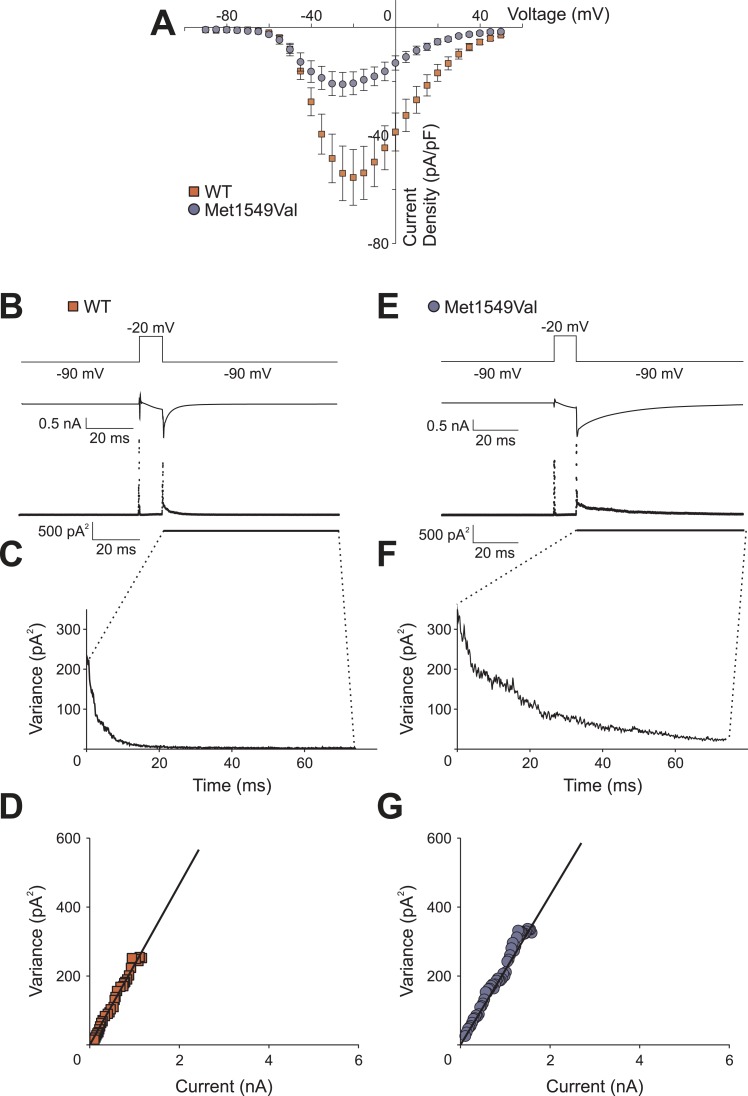
CACNA1HM1549V and CACNA1HWT whole-cell current densities and non-stationary noise analysis.(A) Whole-cell peak currents were divided by the cell capacitance as determined by the amount of capacitance compensation. CACNA1HM1549V shows a decreased current density compared to CACNA1HWT albeit with large variability. (B, E) Representative mean currents from more than 200 traces recorded from one cell expressing CACNA1HWT (B) or CACNA1HM1549V (E) channels. (C, F) Analysis of the variance at the −90 mV tail pulse reveals a time dependent decrease. (D, G) A plot of the variance vs the current only allows for a small initial part of the expected parabolic distribution to be visible. Linear fits (black line) reveal similar single channel amplitudes (CACNA1HWT: 273.7 ± 3.2 fA, n = 3; CACNA1HM1549V: 285.0 ± 17.3 fA, n = 6; p = 0.67), but cannot be used to determine absolute open probabilities. Source files are available in Figure 6—source data 1.